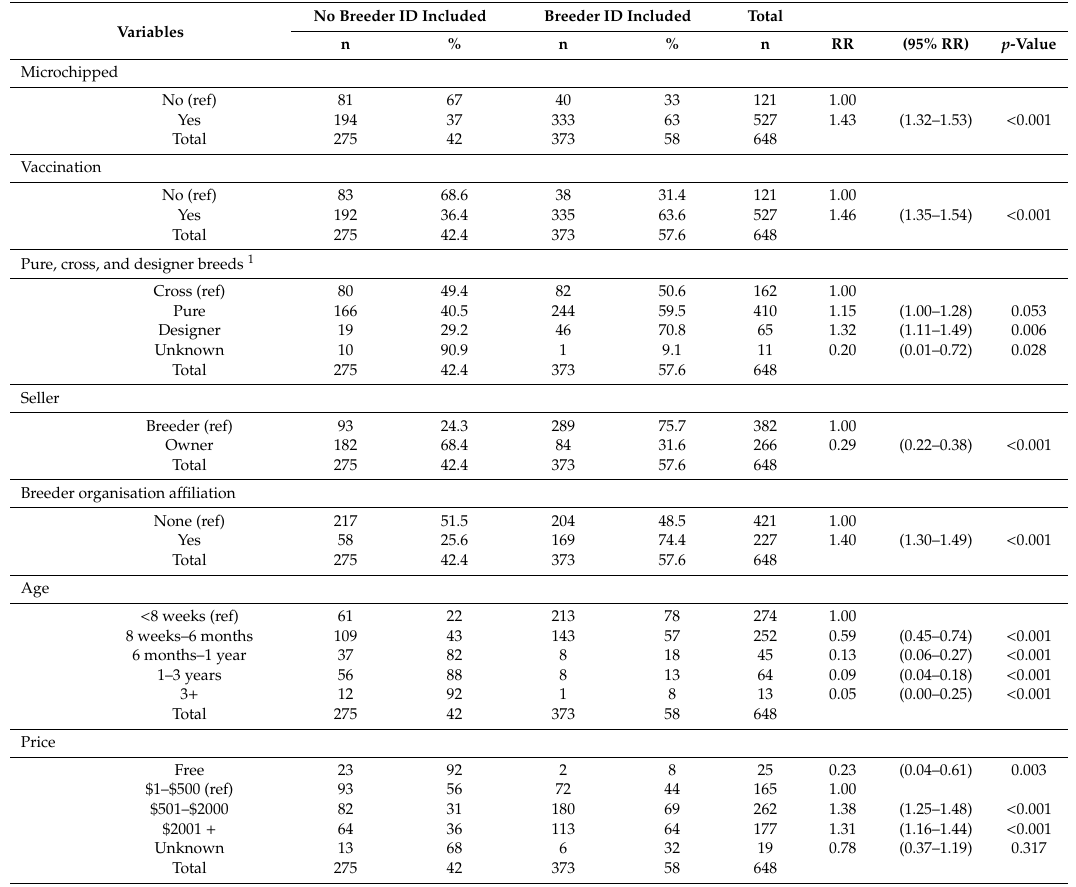
Table 6. Univariate analysis of factors associated with advertisements listing breeder ID’s from two individual webscrapes from Gumtree dog and puppy advertisements (25 March and 8 April 2019) in Australia. Only states with breeder ID regulations were included in this analysis (QLD, SA, VIC). SA advertisements only included those selling animals born prior to 1 July 2019, QLD advertisements only include animals born on or prior to 26 May 2017, as ID regulations do not apply to older animals. Dogs with no age details and shelter / rescue advertisements have been excluded from all states. Predictors have been grouped for ease of interpretation with the reference indicated with a (ref) and relative risk (RR) of 1. A p -value of < 0.05 was considered